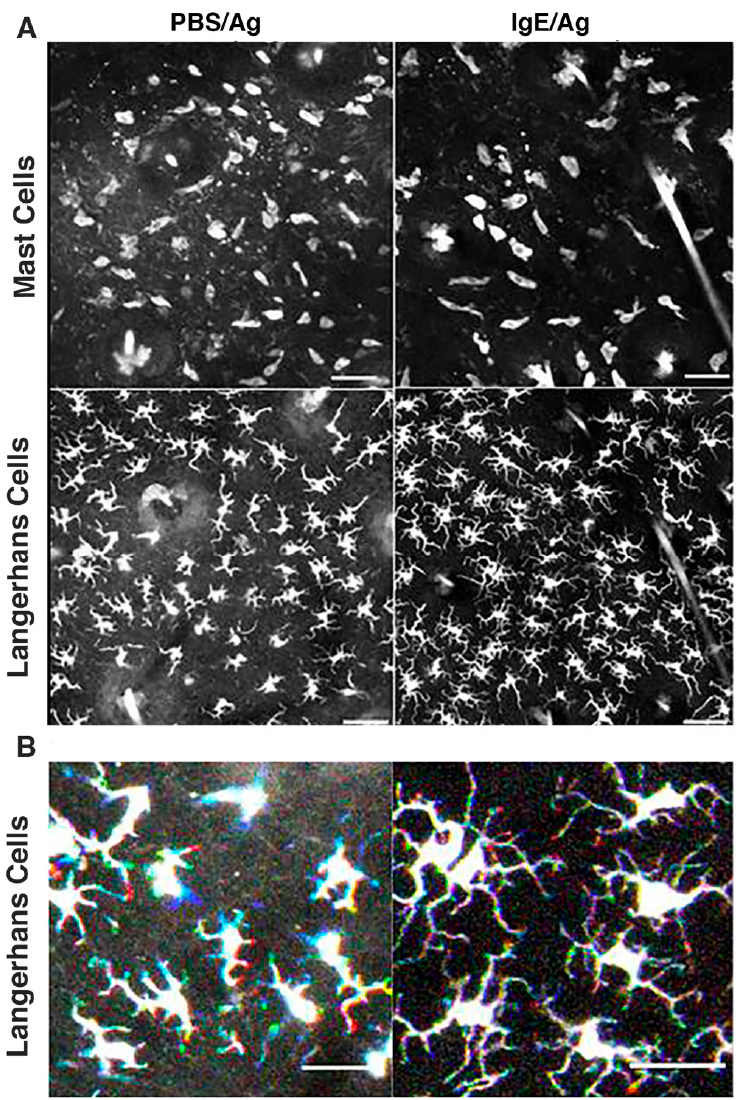
Figure 6. LCs are sessile and exhibit constant sprouting before and after PCA. RMB mice were crossed with knock-in Langerin-eGFP mice and subjected to intravital confocal imaging of ear skin to unravel motility of Langerin-eGFP + LCs in control PBS-sensitized (PBS/Ag) and IgE-sensitized (IgE/Ag) ear skin 3 h after Ag challenge. Dual fluorescence 4D data sets with Z thickness of 45 µm and 3 µm Z step size are processed as for dual channel Foxp3-eGFP + Treg/tdT + MC data sets of Figure 4. ( A ) compares general appearance of Langerin-eGFP + LCs and tdT + MCs. ( B ) To visualize mobility of Langerin-eGFP + LCs, the merge of three sequential time points (0 min, 7 min and 14 min) of an RGB image is represented as in Figure 1A. LCs are sessile and cell body appears in white, while their dendrites emerge with red or blue colored extremities in RGB mode both in control and PCA subjected ears. Scale bar ( A ) 50 µm and ( B ) 30 µm. Typical micrographs were extracted from a pool of experiments performed in three mice.